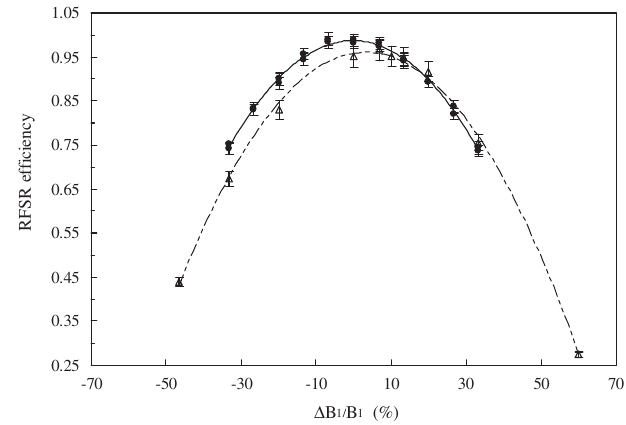
FIG. 8. The measured efficiencies of the RFSR using the RFSR-flip method ( 4 ) and the AFP 3 He flip method ( (cid:20) ) are plotted as a function of a relative change in the rf field, (cid:2) B The dashed and solid curves are quadratic fits to data.